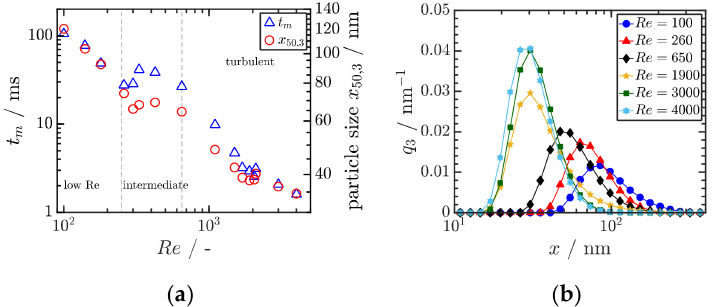
Figure 8. ( a ) Correlation between the experimentally determined mixing time t m and the mean particle as function of the Reynolds number Re. Reprinted with permission from [50], Wiley, 2019. ( b ) Measured particle size distributions in dependence of Re. Both results are obtained for Ibuprofen. Reprinted with permission from [50], Wiley,